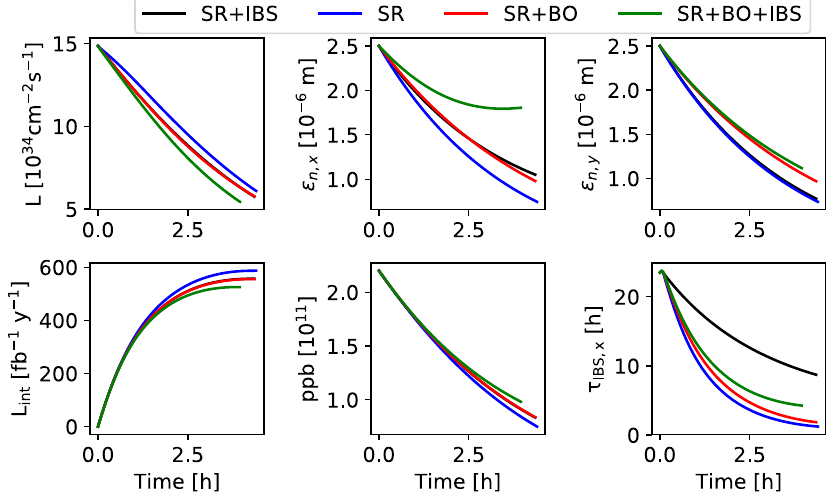
FIG. 8. Simulated physics for HE-LHC, including synchrotron radiation (SR), intrabeam scattering (IBS) or emittance growth due to burn-off (BO).